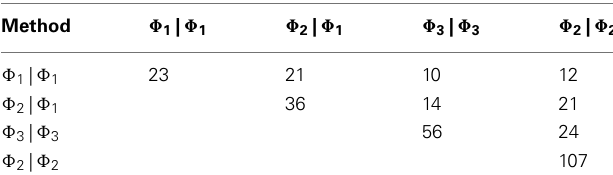
Table 4 |Agreement of significance